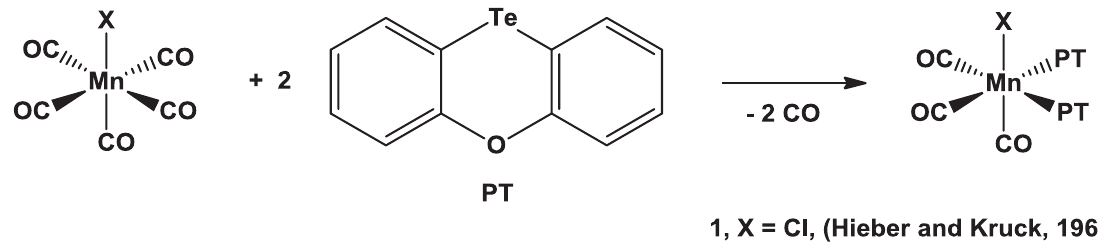
Table 1: Crystal data and structure refinement